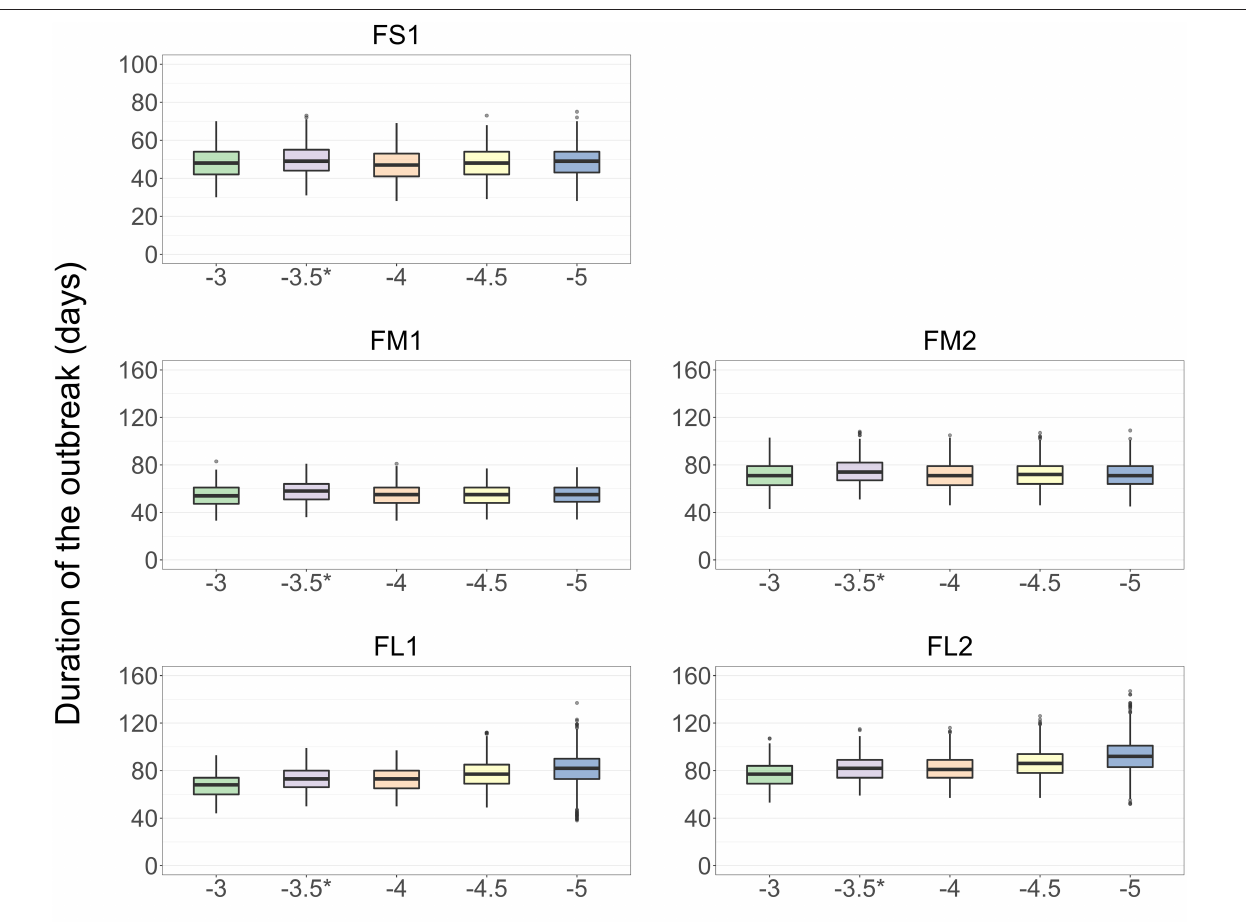
FIGURE 7 | Boxplot of the projected duration of a foot-and-mouth disease outbreak on a U.S. beef cattle feedlot for n = 2,000 simulated outbreaks in the feedlot of that size and layout sampling the values of the target parameters, depending on the power ( α ) of the function of an exponential decay in the probability of airborne FMD virus transmission with increasing distance between home-pens. *Baseline value used to simulate the models for the other analyses. Feedlot size and layout cases modeled: FS1 is a 4,000 cattle feedlot with one hospital-pen; FM1 is a 12,000 cattle feedlot with one hospital-pen; FM2 is a 12,000 cattle feedlot with two hospital-pens; FL1 is a 24,000 feedlot with two hospital-pens; and FL2 is a 24,000 cattle feedlot with four hospital-pens (in all the layouts n = 200 cattle per home-pen).